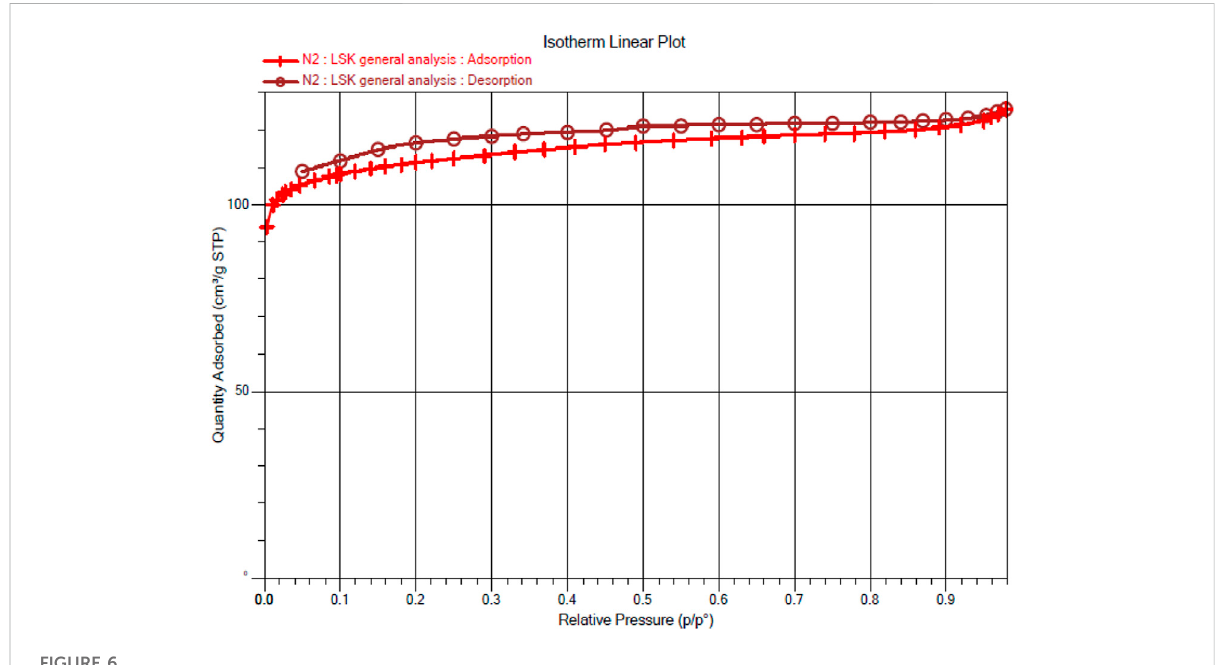
FIGURE 6 Nitrogen sorption isotherm of Ce-MOF.